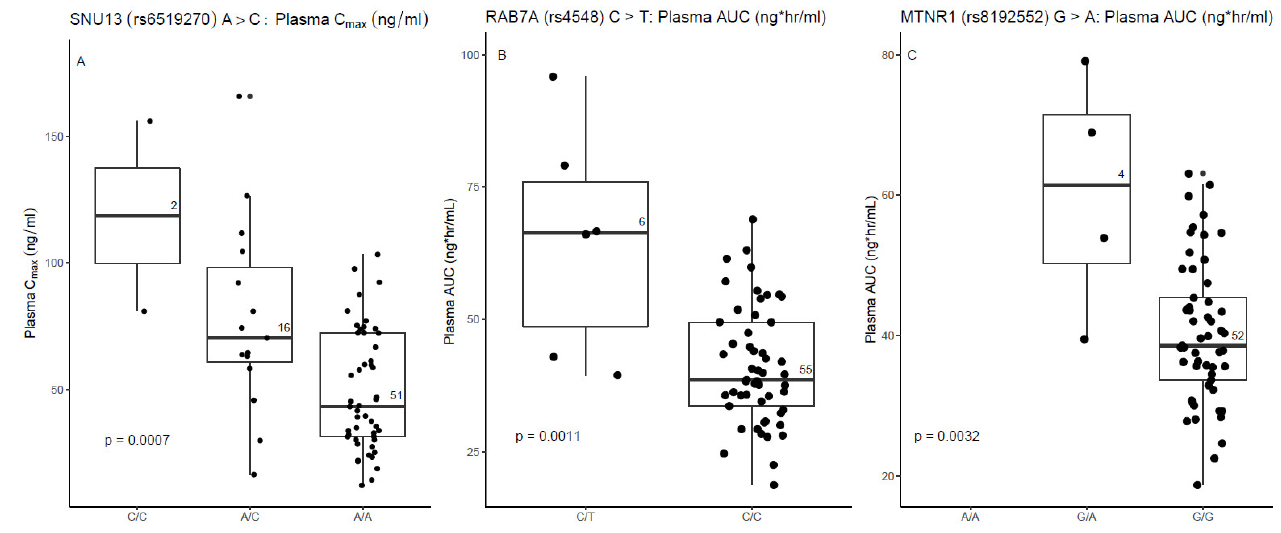
Figure 1. ( A ): Association between a SNP in SNU13 and vincristine (VCR) pharmacokinetics (PK).